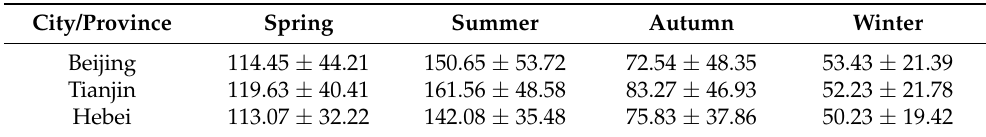
Figure 5. Distribution of O 3 _8h concentration in different seasons during 2018 to 2020 in Jing-Jin-Ji region in China. Table 3. Averaged ozone concentrations and the standard deviation in different seasons from 2018 to 2020 in Jing-Jin-Ji region in China (μg/m³).